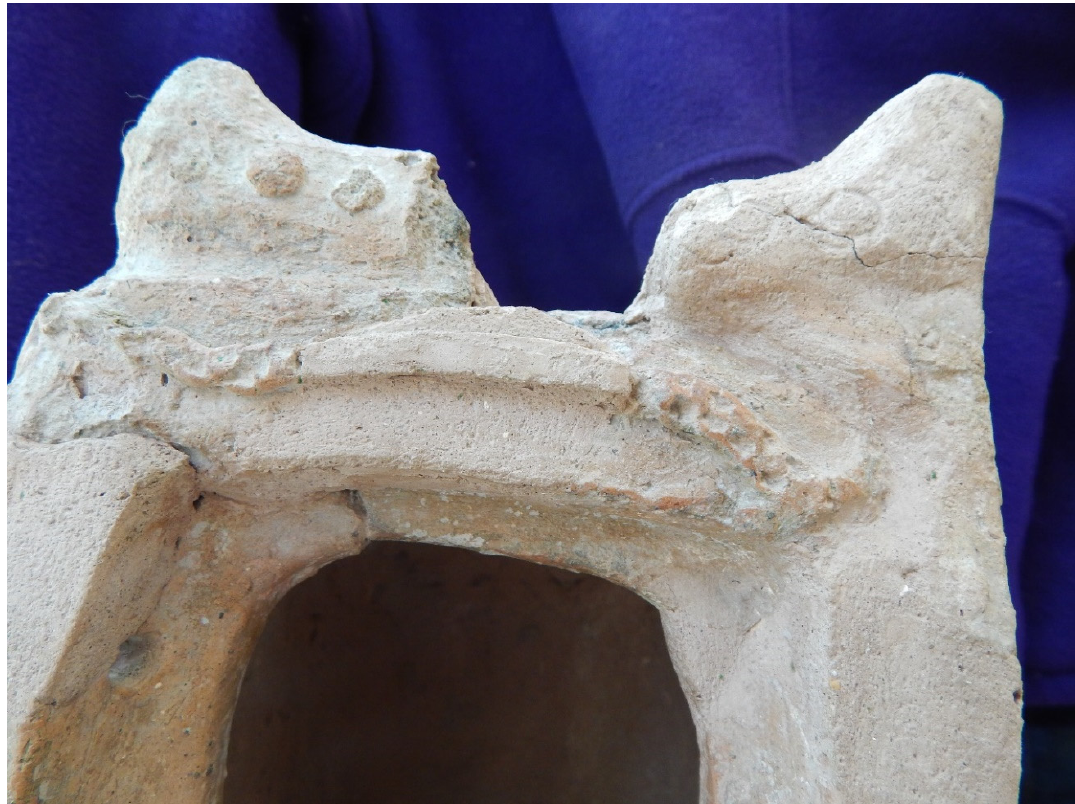
Figure 16. Close-up of the upper façade of the Tel Rekhesh shrine model (photograph by the authors).